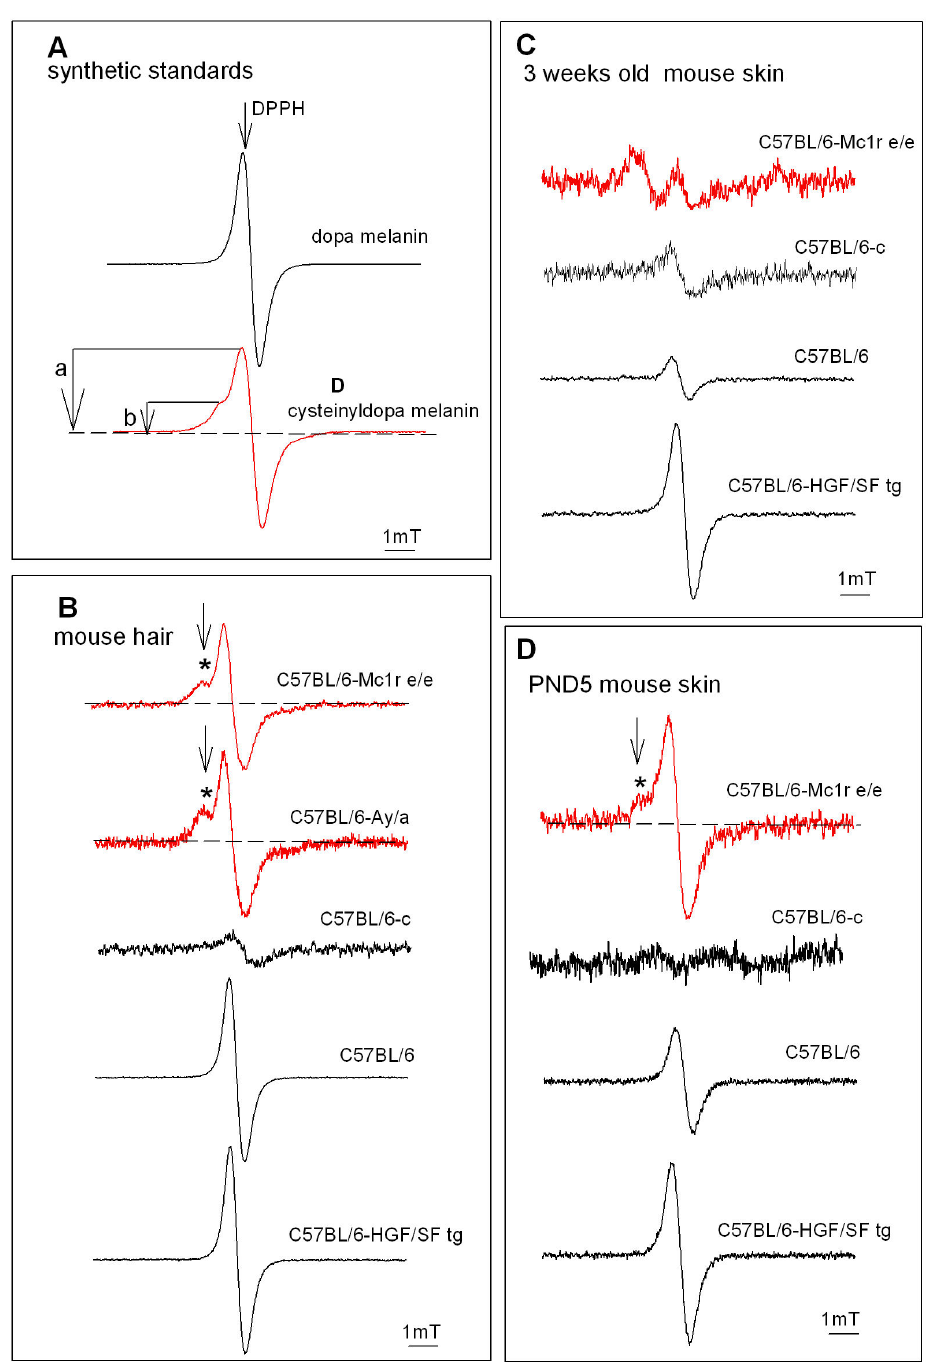
Figure 3. EPR spectra of the investigated materials. DPPH (1,1-diphenyl-2-picrylhydrazyl) – marker for the position of the free radical signal